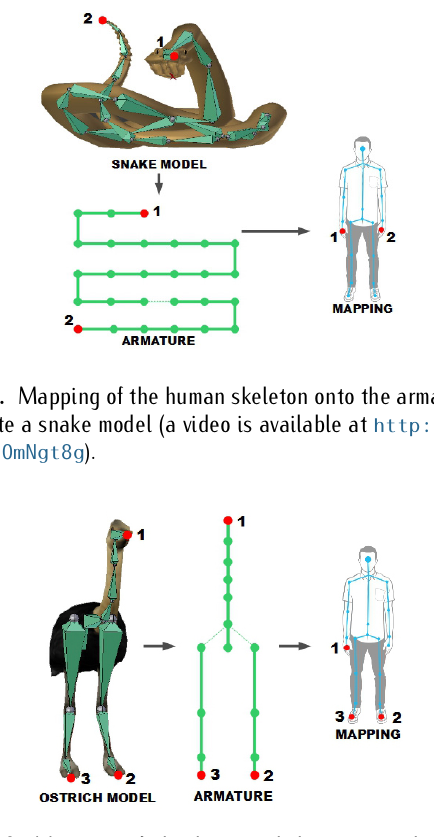
Figure 10. Mapping of the human skeleton onto the armature used to animate an ostrich model (a video is available at http:// youtu.be/sM_ZiHVHFtY